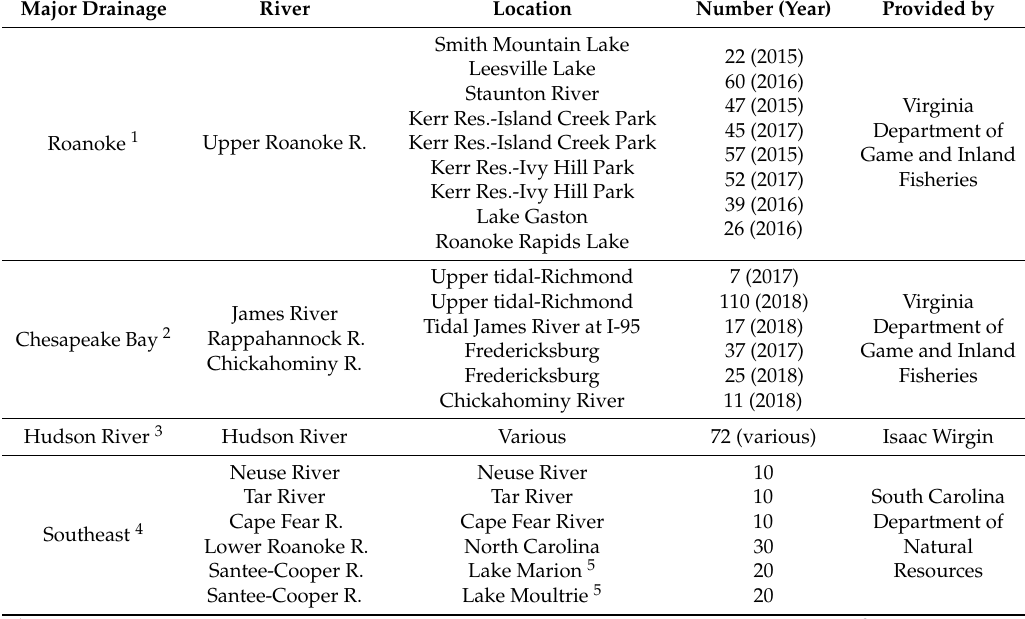
Table 1. Striped bass collections characterized for microsatellite DNA variation. Total samples, n =